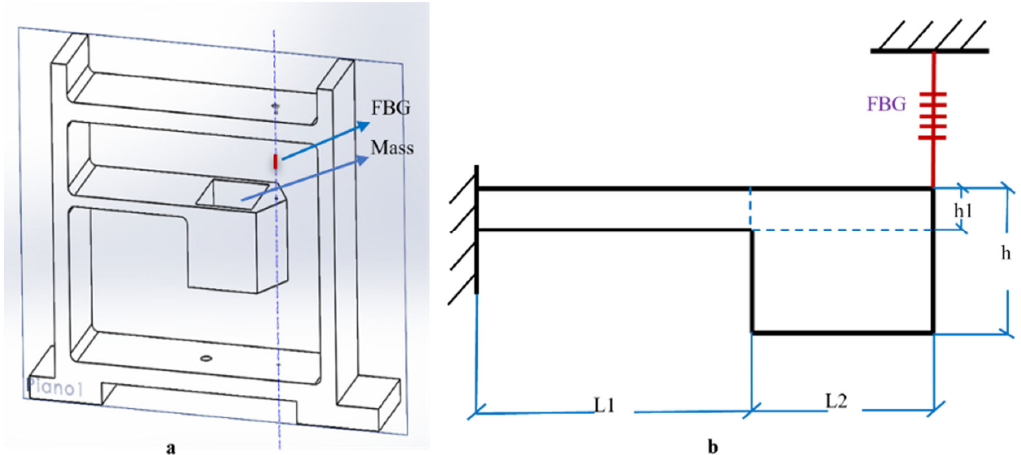
Figure 1. Structure of the cantilever ‐ based FBG sensor: ( a ) system 3D rendering generated by Solid Works (2020); ( b ) schematic section of the cantilever. Works (2020); ( b ) schematic section of the